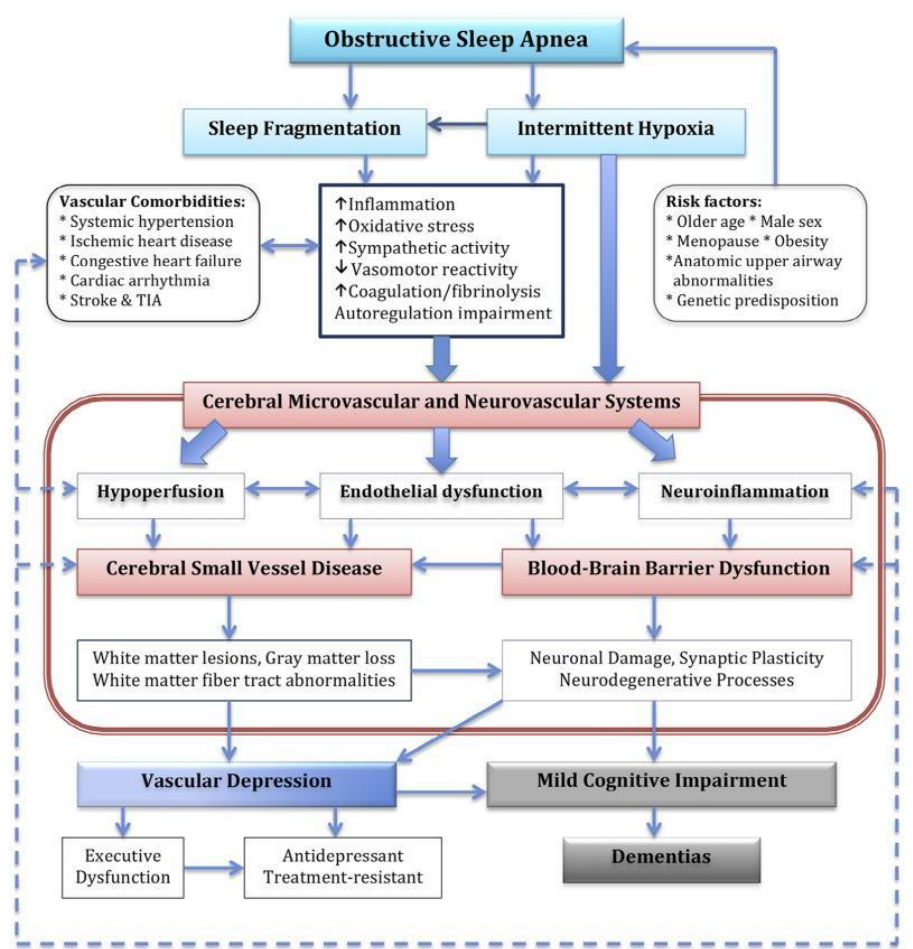
Figure 1. Describes the variety of pathophysiological changes within OSA leading to dementia. Given the number of overlapping processes, there are a variety of contributory mechanisms leading to or aggravating underlying dementia. TIA: Transient ischemic attack. The figure adapted from [4], with permission from Elsevier, 2016.